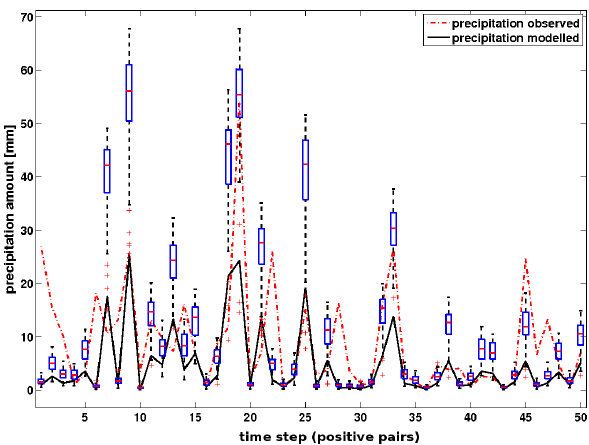
Fig. 13. Copula-based stochastic simulations of 50 consecutive positive pairs (precipitation > 0.01mm) performing 100 realizations (illustrated as box-whiskers) of V (observed rainfall at gauge, illustrated as red line) assuming that U (corresponding coarse scale MM5 precipitation, illustrated as black line) is known. The boxes have lines at the lower Q1 and upper quartile Q3 and the median values Q2 (middle horizontal lines). The whiskers (vertical lines) are lines extending from each end of the boxes to show the extent of the rest of the data. The maximum length of the whiskers is determined by 1.5 ( Q3 – Q1 ). Outliers (crosses) are data with values beyond the ends of the whiskers.